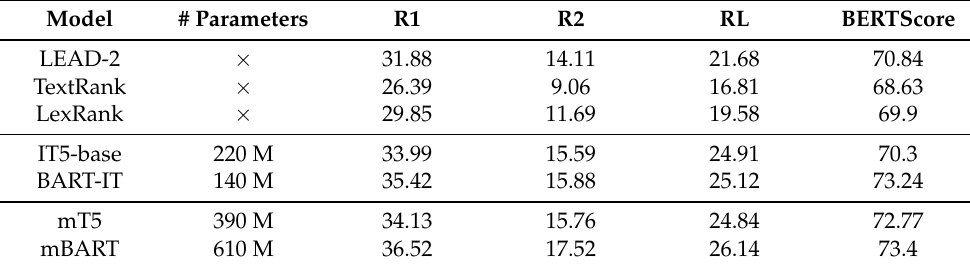
Table 3. Summarization evaluation results on the FanPage dataset. The # parameters column is empty for unsupervised baseline models since they do not include any trainable